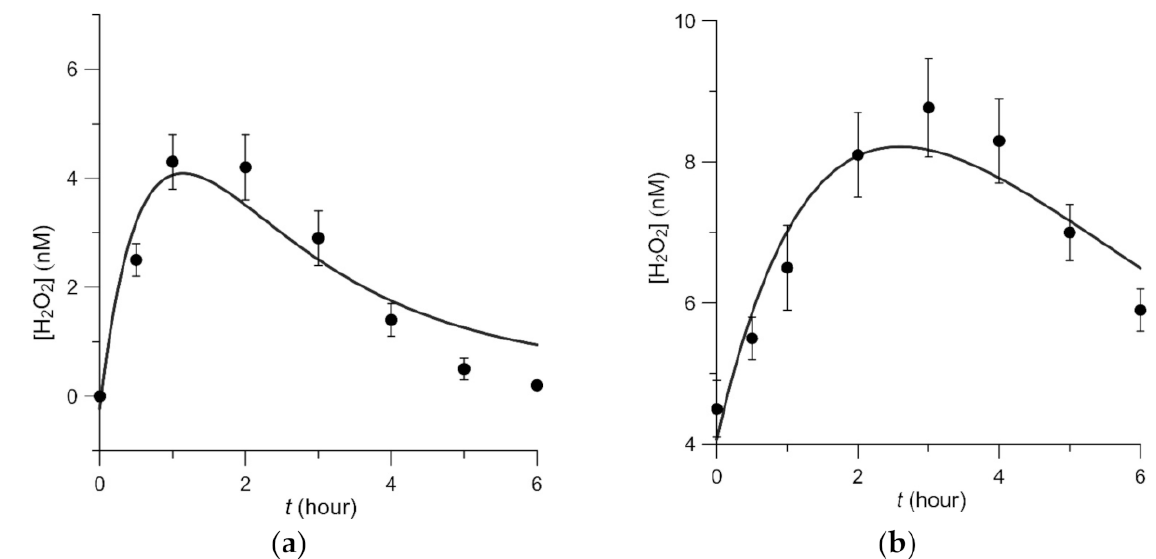
Figure 5. Dynamics of hydrogen peroxide generation in solutions of proteins exposed to laser radiation He–Ne laser (3 mW) for 15 min in phosphate buffer (10 mM Na 2 HPO 4 and 150 mM NaCl, pH 7.4): ( a ) BGG (2 µ M); ( b ) BSA (10 µ M). The circles are experimentally measured H 2 O 2 concentrations. The solid lines display theoretical approximation of the experimental points by Levenberg–Marquardt